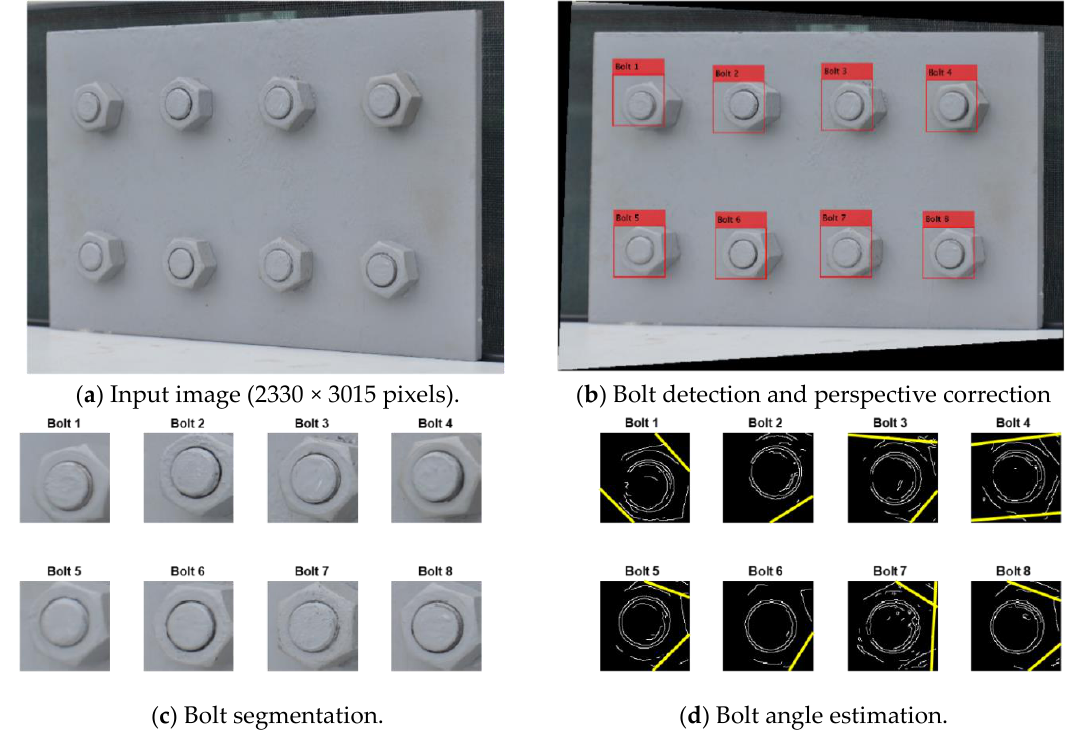
Figure 9. The representative results of the lab-scaled connection image with a 30° horizontal perspective.